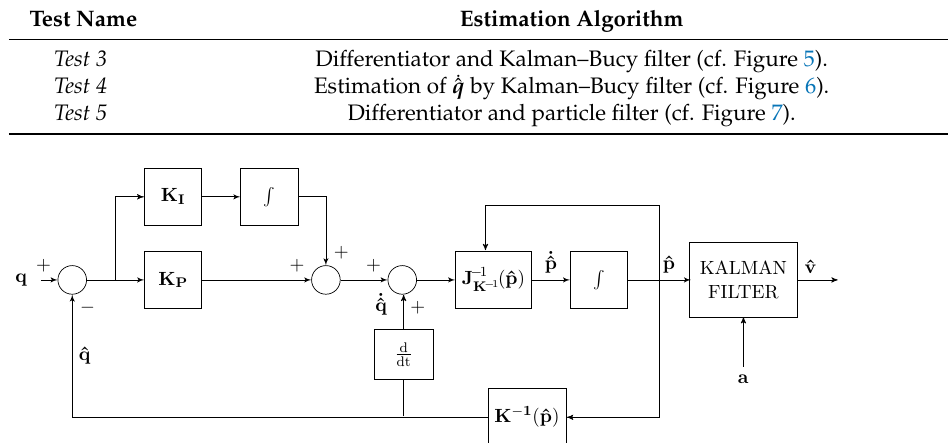
Figure 5. Test 3 estimator scheme with Kalman filter and differentiator.